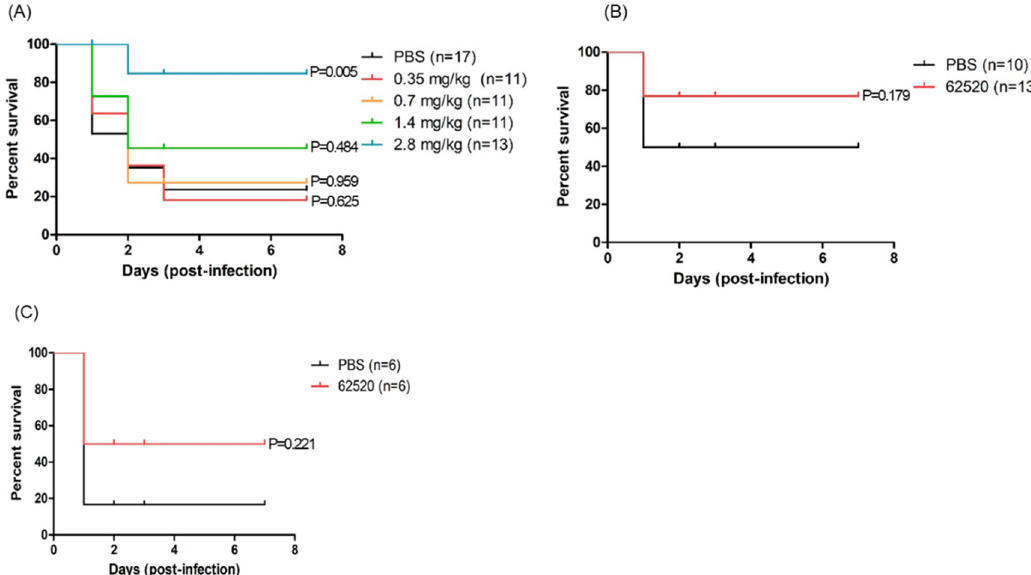
Figure 4. Survival rates of A. baumannii -infected mice treated with compound 62520. The survival of mice was evaluated for 7 days after bacterial infection. ( A ) Neutropenic mice were infected with 5 × 10 8 CFUs of A. baumannii ATCC 17978 and, after 2 h, they were injected with different doses of compound 62520. ( B ) Immunocompetent mice were infected with 1.0 × 10 9 CFUs of A. baumannii ATCC 17978 and, after 2 h, they were injected with 2.8 mg/kg of compound 62520. ( C ) Immunocompetent mice were infected with 2.0 × 10 8 CFUs of A. baumannii 2140 and, after 2 h, they were injected with 5.6 mg/kg of compound 62520. All control mice were injected with 100 μ L of PBS.